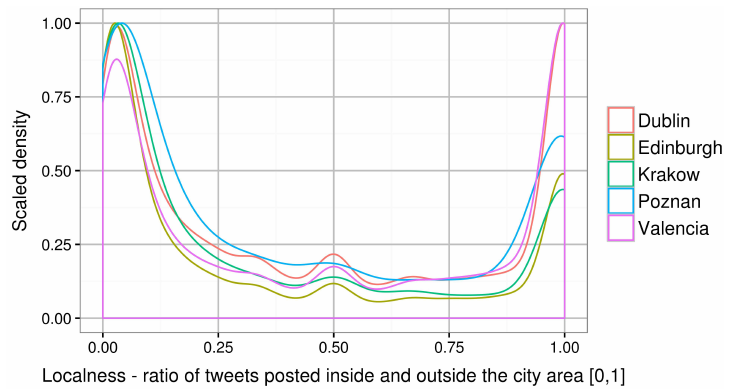
Figure 4. Localness index in selected cities. Based on comparison between D1 and D2.